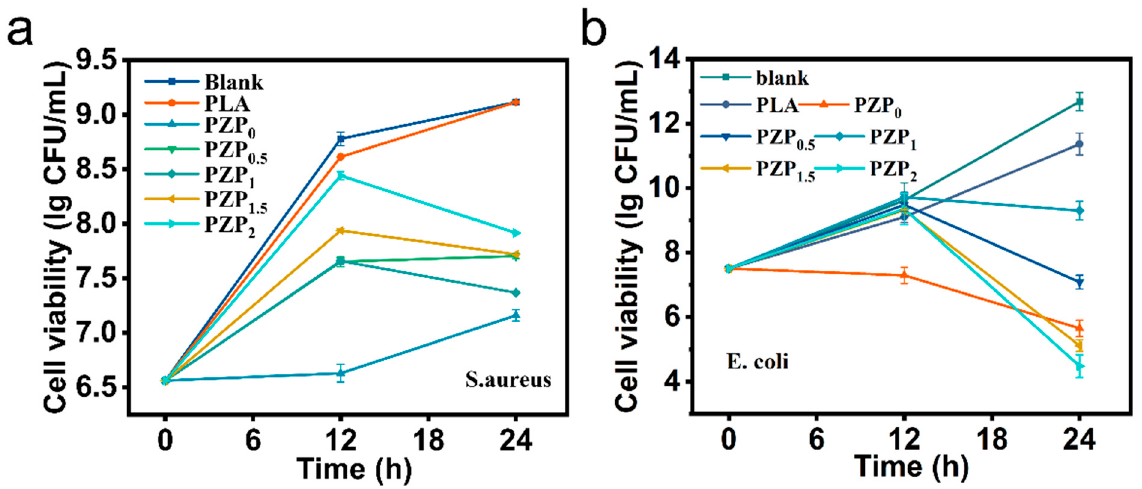
Figure 6. Antimicrobial activity of PLA-based composite films against (a) S. aureus and (b) E. coli .